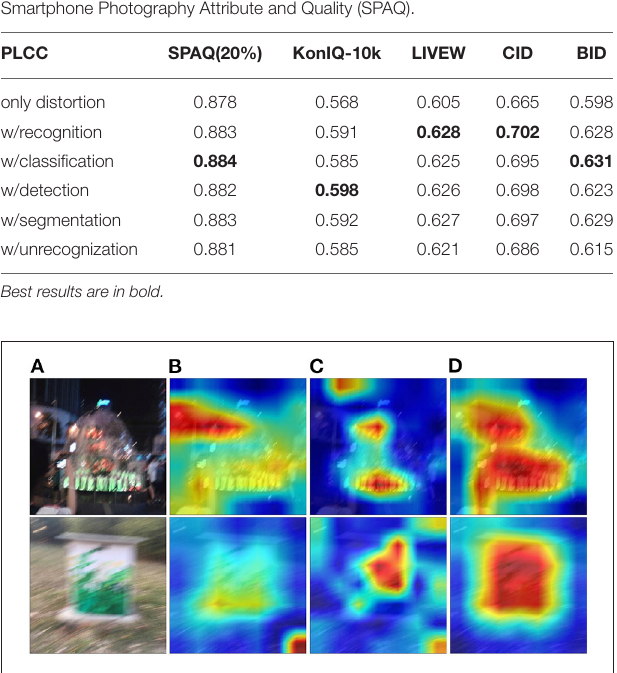
FIGURE 7 | Visualization results of Grad-CAM. (A) Original images; (B) heat-maps of the baseline model; (C) heat-maps of the intelligibility network; (D) heat-maps of proposed model with image recognition task.